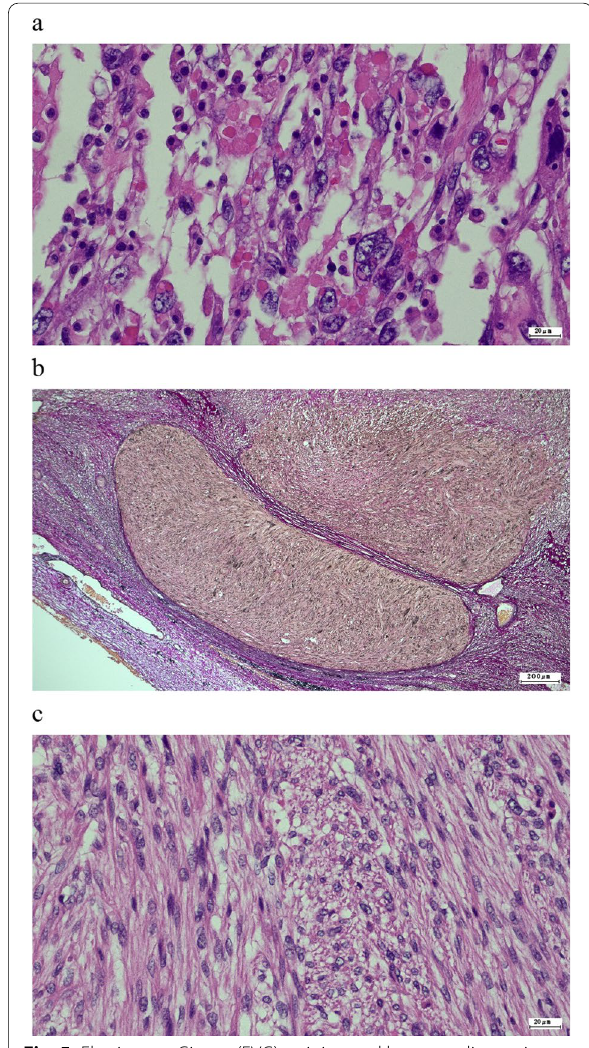
Fig. 5 Elastica van Gieson (EVG) staining and hematoxylin–eosin (HE) staining reveal that the majority of the tumor has a pleomorphic pattern ( a ), whereas only intravascular tumor cells of the mesenteric vein are uniformly well-differentiated cells ( b , c